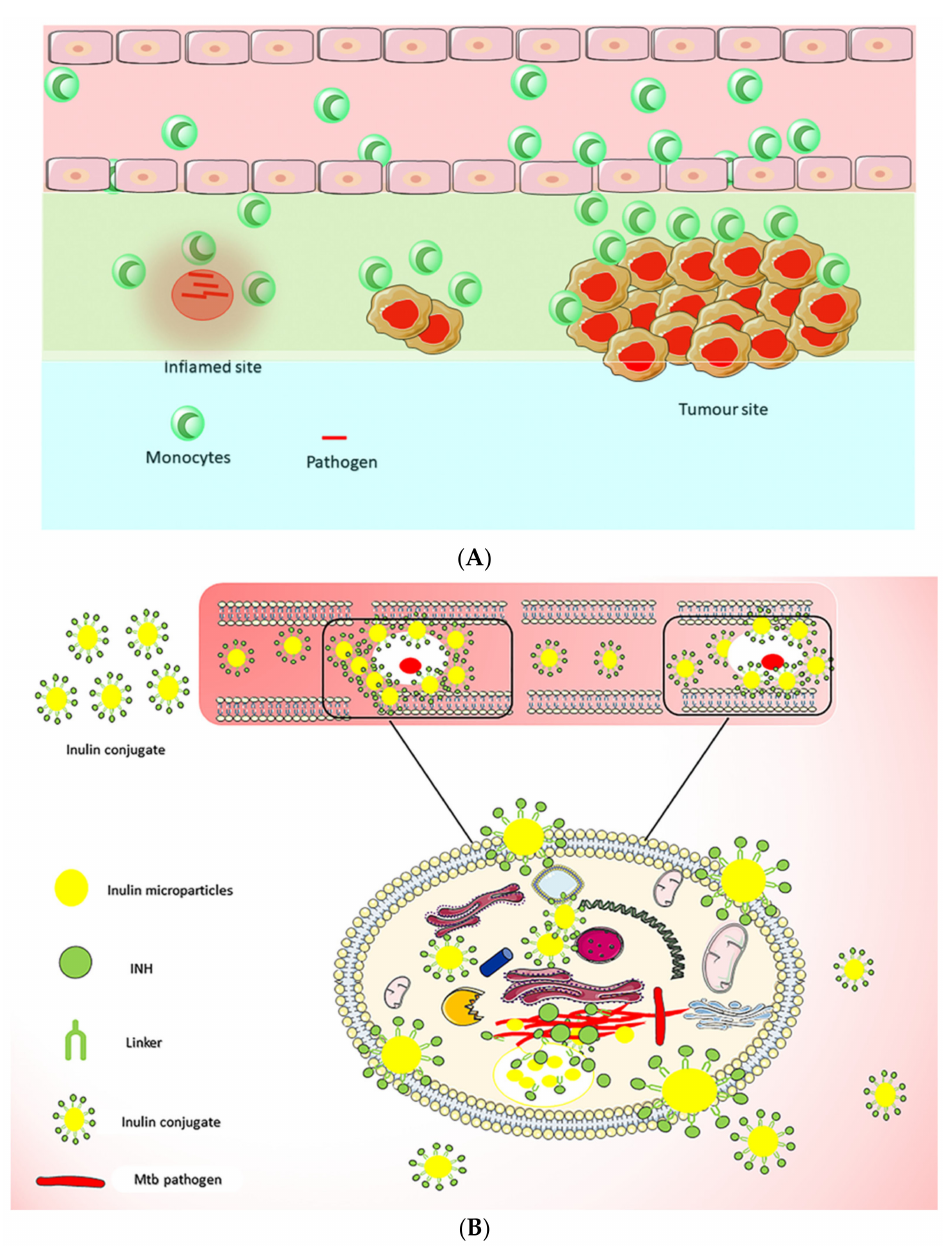
Figure 8. ( A ) schematic diagram showing monocytes targeted delivery to inflamed and tumor site. ( B ) Isoniazid intracellular targeted delivery to infected monocytes with inulin microparticles. Reprinted from